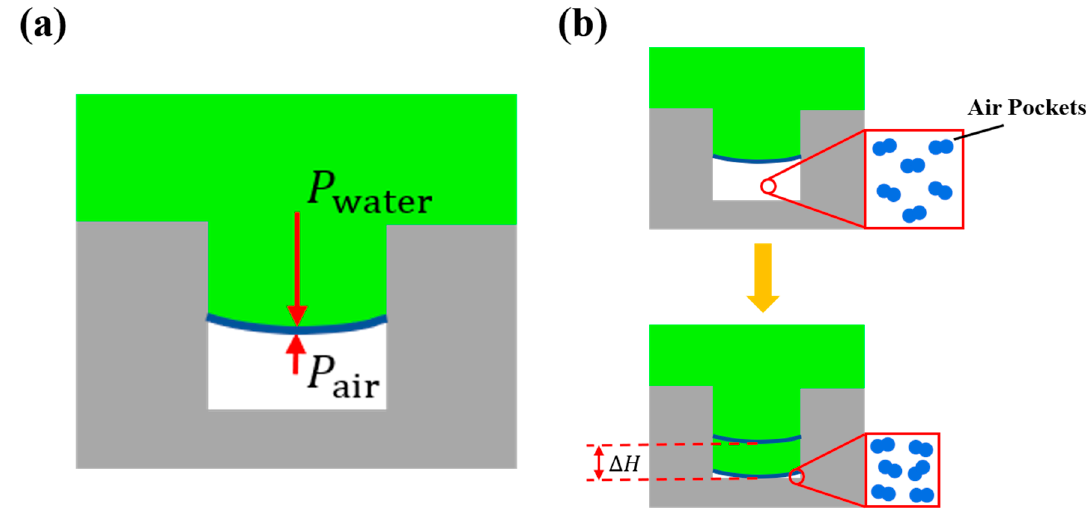
Figure 5. ( a ) Schematic diagram of the force at the liquid-air interface. ( b ) Schematic diagram of continuous contraction of air pockets on cooling to overcome resistance in the C-W wetting transition.